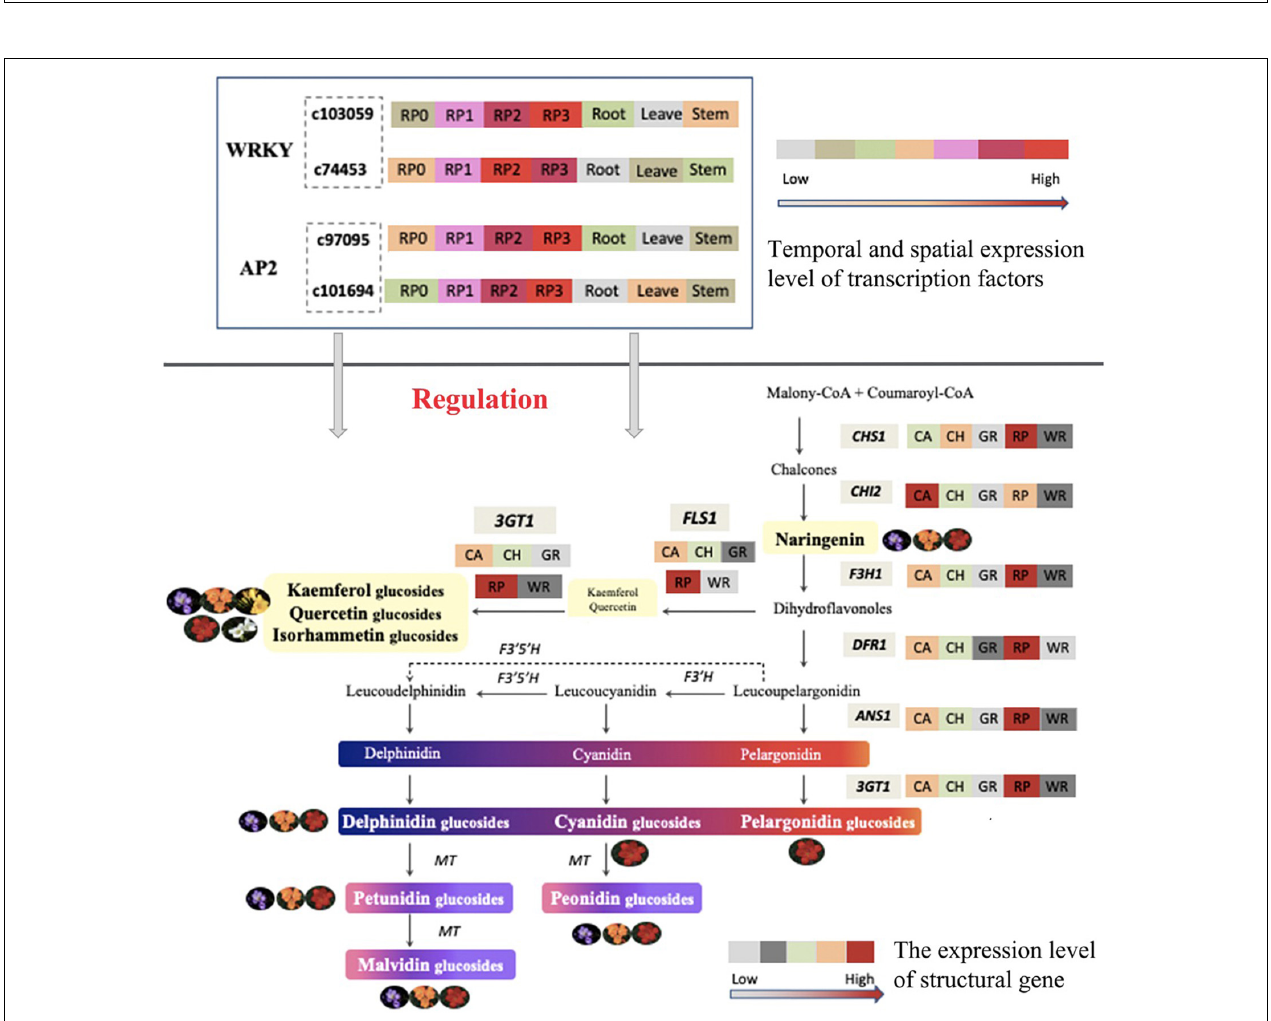
FIGURE 10 | Proposed model of the metabolism and gene regulation of flavonoid in the petals of Freesia .